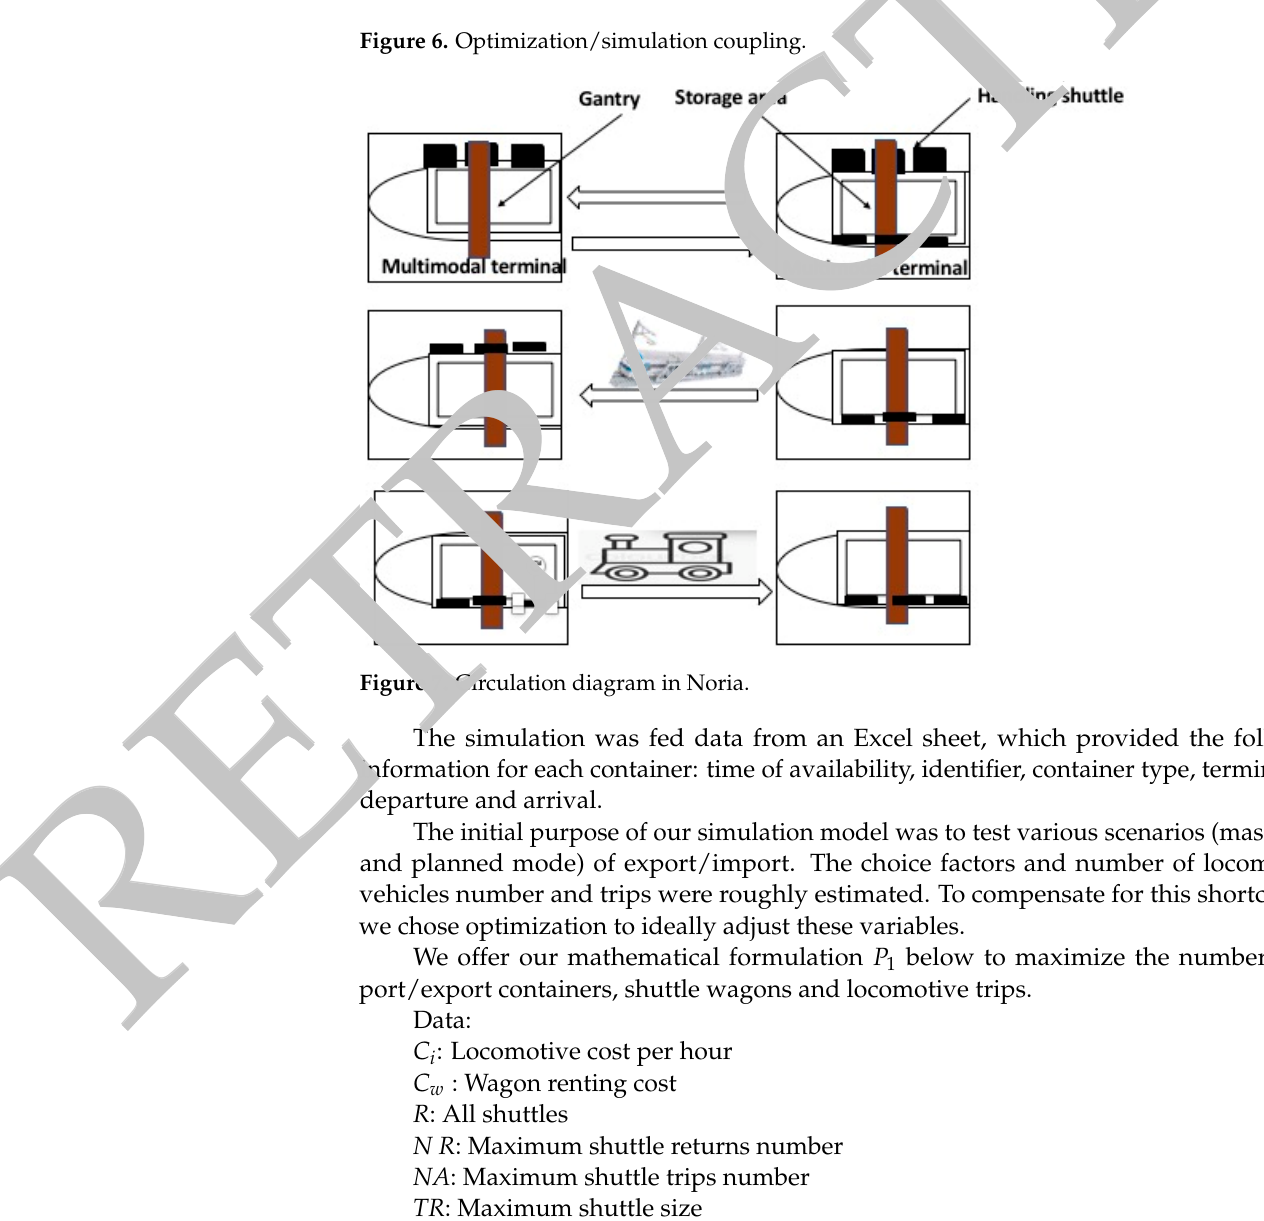
Figure 6. Optimization/simulation coupling.